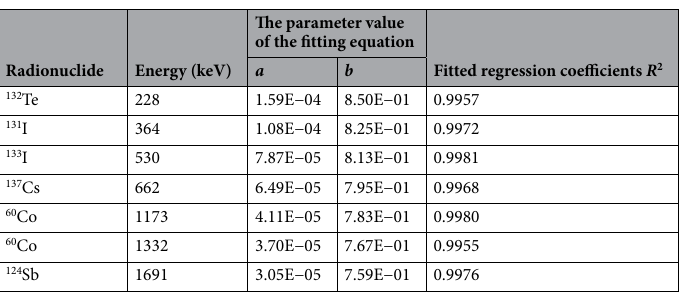
Table 2. The parameter value of the fitting equation for detection efficiency.